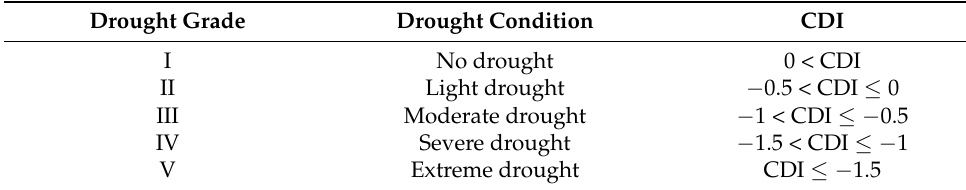
Table 9. CDI classification criteria for grading drought events.